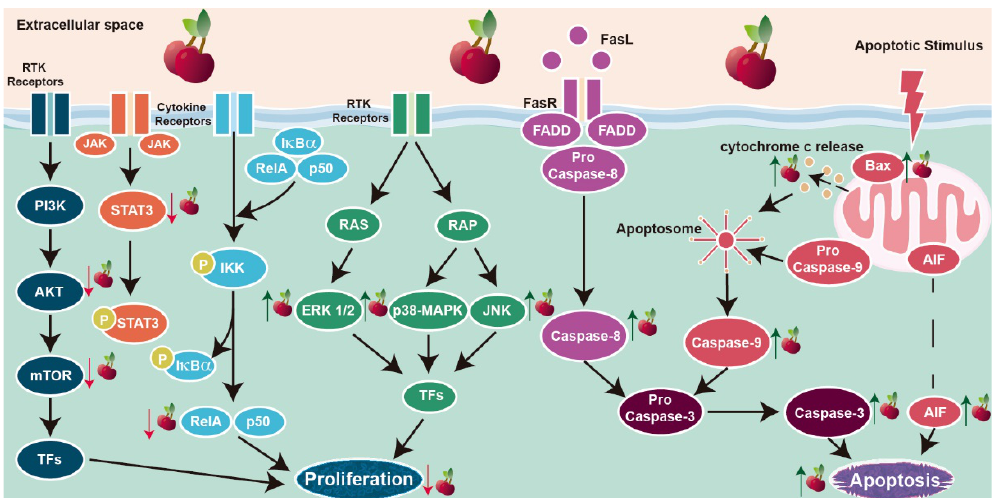
Figure 2. Sweet cherries effects in modulating the intracellular signaling that governs cancer cell proliferation and apoptosis. Regardless of anthocyanins or proanthocyanins enrichment, sweet cherry extracts reduced cell proliferation and induced apoptosis with altered expression and/or activity of several molecular targets. However, extracts enriched in anthocyanins or proanthocyanins can influence specific molecular targets (see text for details). Overall, mechanistically, the phosphoinositide 3-kinase (PI3K) pathway was inhibited with the mechanistic target of rapamycin (mTOR) and AKT as targets. Cytokine receptors signaling could also be influenced by sweet cherry extract, namely by the modulation of signal transducer and activator of transcription (STAT) 3 and nuclear factor kappa-light-chain-enhancer of activated B cells (NF- κ B or RelA/p50). In the mitogen-activated protein kinase (MAPK) pathway, altered activity of p38-MAPK, extracellular signal-regulated kinase (ERK) 1/2, and c-Jun N-terminal kinase (JNK) was reported. Concerning apoptosis, the sweet cherry extract enriched in anthocyanins influenced both the extrinsic (caspase-8) and intrinsic (B-cell lymphoma 2-associated X protein (Bax), apoptosis-inducing factor (AIF), cytochrome c release, caspase-9) pathways, culminating in the activation of caspase-3. Whole sweet cherry extract or extract enriched in proanthocyanins activated only the intrinsic pathway (Bax, AIF, caspase-9 and -3, and cytochrome c release). Green and red arrows mean up- and down-regulation of expression and/or activity, respectively. Legend: FADD, Fas-associated protein with death domain; FasL, Fas ligand; FasR, Fas receptor; I κ B α , nuclear factor of kappa light polypeptide gene enhancer in B-cells inhibitor, α ; IKK, I κ B kinase; JAK, Janus Kinase; RAP, Ras proximate; RTK, Receptor tyrosine kinase; TFs, Transcription